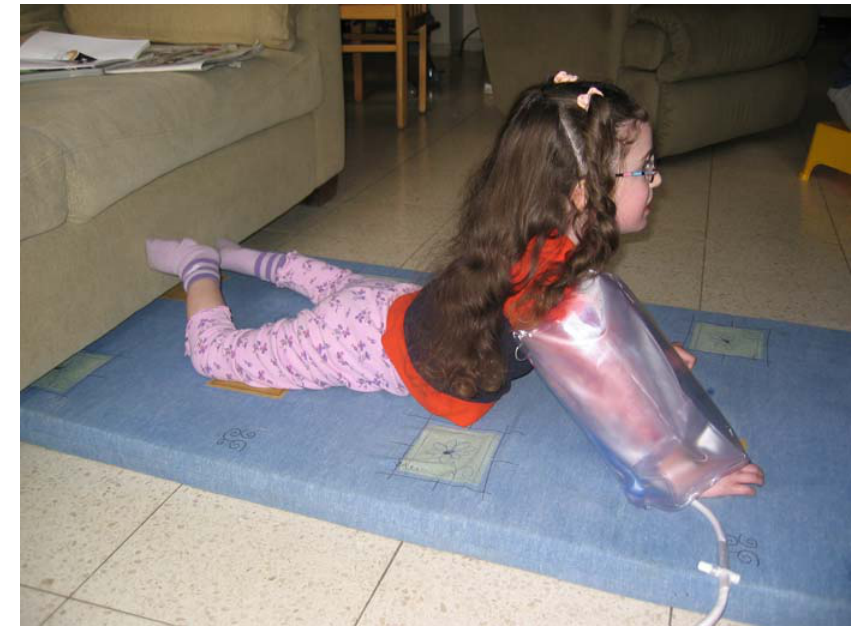
PICTURE 2. A child with plastic elbow supports.